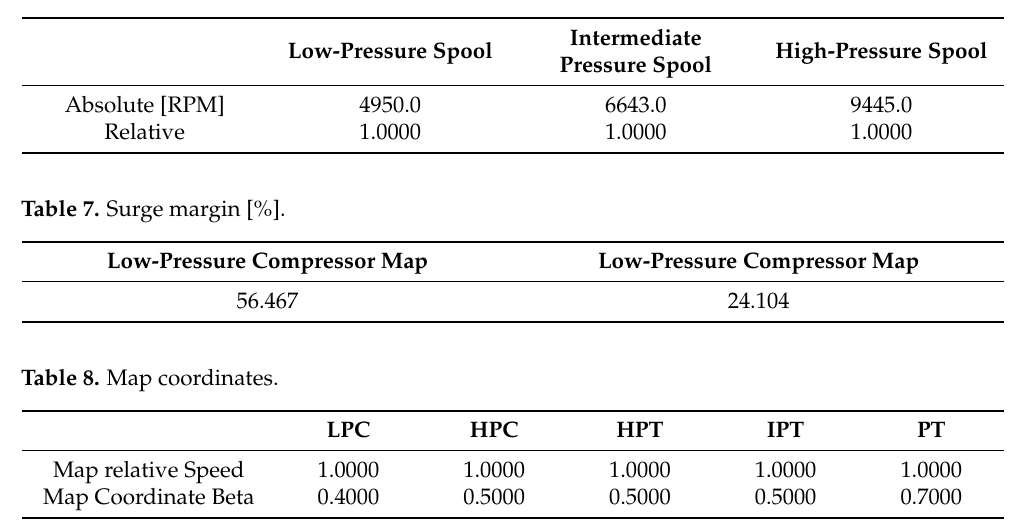
Table 6. Spool speeds.